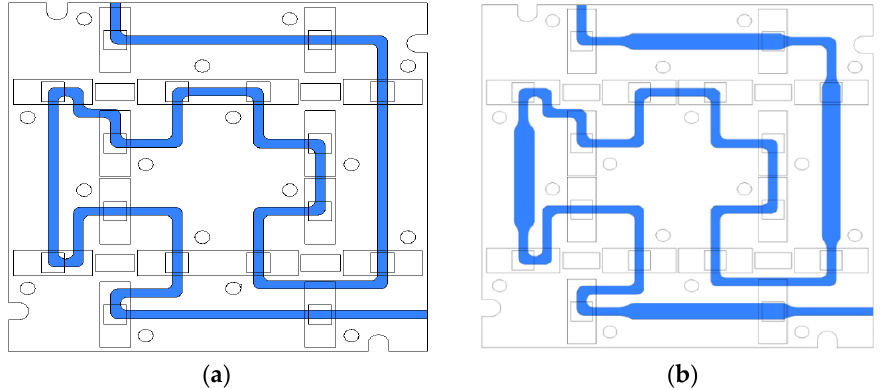
Figure 3. Schematic diagram of expansion of straight channel. ( a ) Original channel; ( b ) broadened channel.